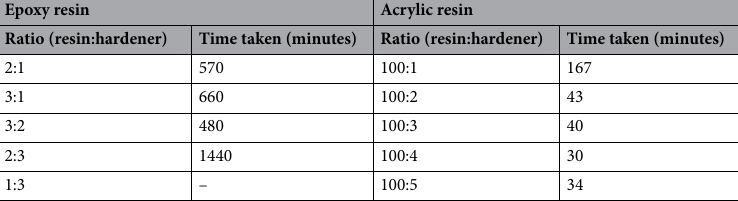
Table 2. Cure time at different ratios of Resin.